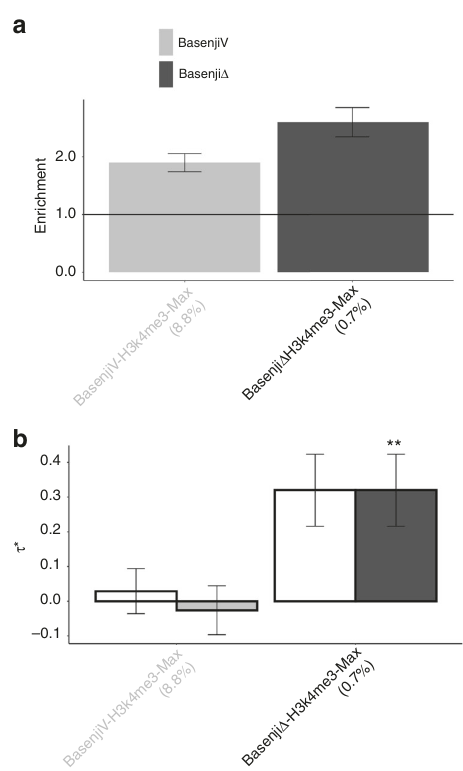
Fig. 2 Disease informativeness of non-tissue-speci fi c allelic-effect deep learning annotations. a Heritability enrichment, conditioned on the non- tissue-speci fi c variant-level joint model. Horizontal line denotes no enrichment. b Standardized effect size τ ⋆ conditioned on either the non- tissue-speci fi c variant-level joint model (marginal analysis: left column, white) or the variant-level joint model plus 1 non-tissue-speci fi c allelic- effect Basenji annotation (Basenji Δ -H3K4me3-Max) (non-tissue-speci fi c fi nal joint model: right column, dark shading. Results are meta-analyzed across 41 traits. Results are displayed only for the allelic-effect annotation (Basenji Δ -H3K4me3-Max) with signi fi cant τ ⋆ in marginal analyses after correcting for 106 (variant-level + allelic-effect) non-tissue-speci fi c annotations tested ( P < 0.05/106), along with the corresponding variant- level annotation; the correlation between the two annotations is 0.43. For non-tissue-speci fi c fi nal joint model (right column), ** P < 0.05/106. Error bars denote 95% con fi dence intervals. Numerical results are reported in Supplementary Table 6 and Supplementary Table